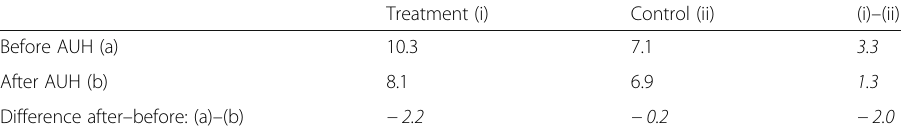
Table 2 Proportion of inactive women entering the labor force. Treatment and control group, before and after AUH Treatment (i) Control (ii) (i) – (ii) Before AUH (a) 10.3 7.1 3.3 After AUH (b) 8.1 6.9